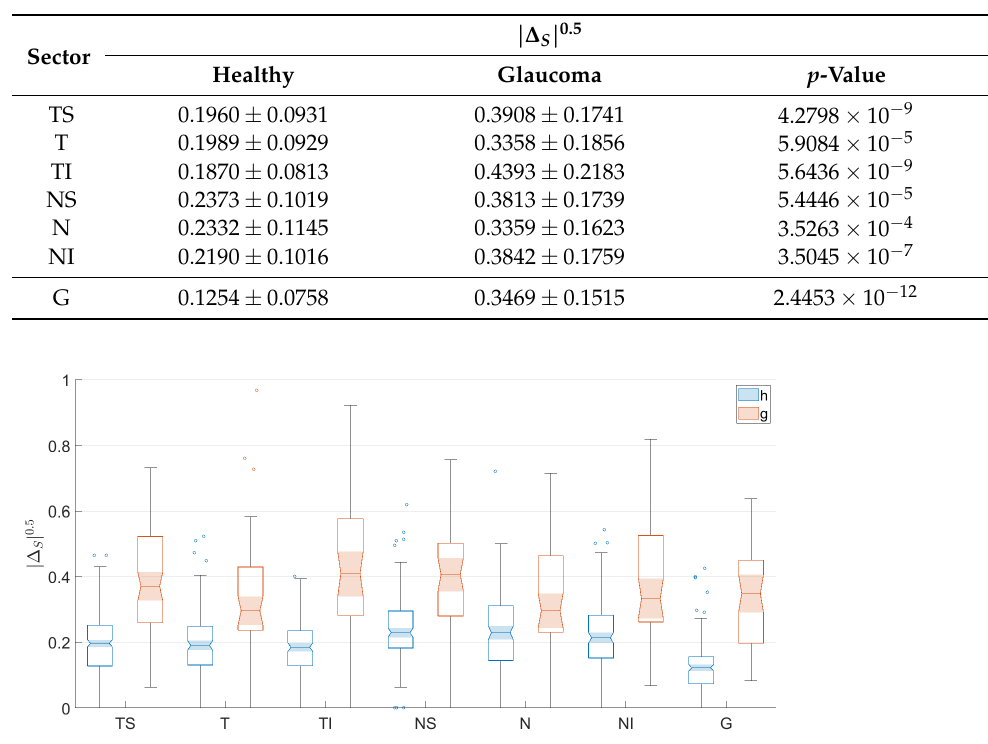
Table 9. Statistical characterization of the asymmetry metric | ∆ S | 0.5 proposed for RNFL thickness. Mean values, standard deviations and p -values of this metric for the two subsets of healthy and glaucoma patients.